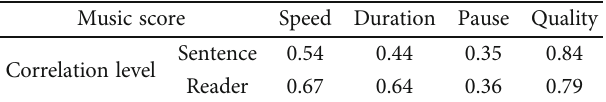
Table 2: The fl uence of the music